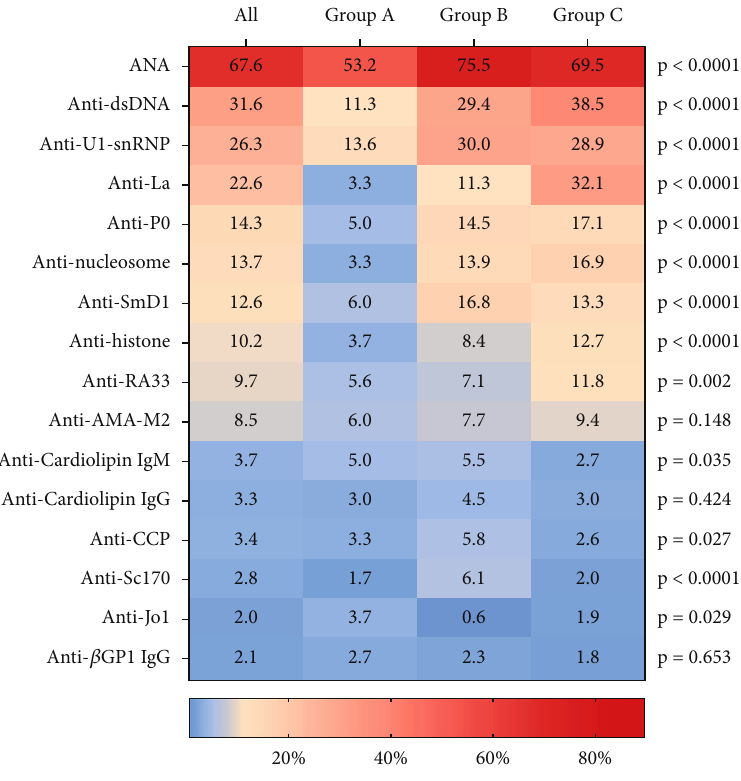
Figure 2: Comparison of autoantibody pro fi les in patients with positive anti-Ro antibodies. Table 2: Comparison of laboratory data in patients with connective tissue